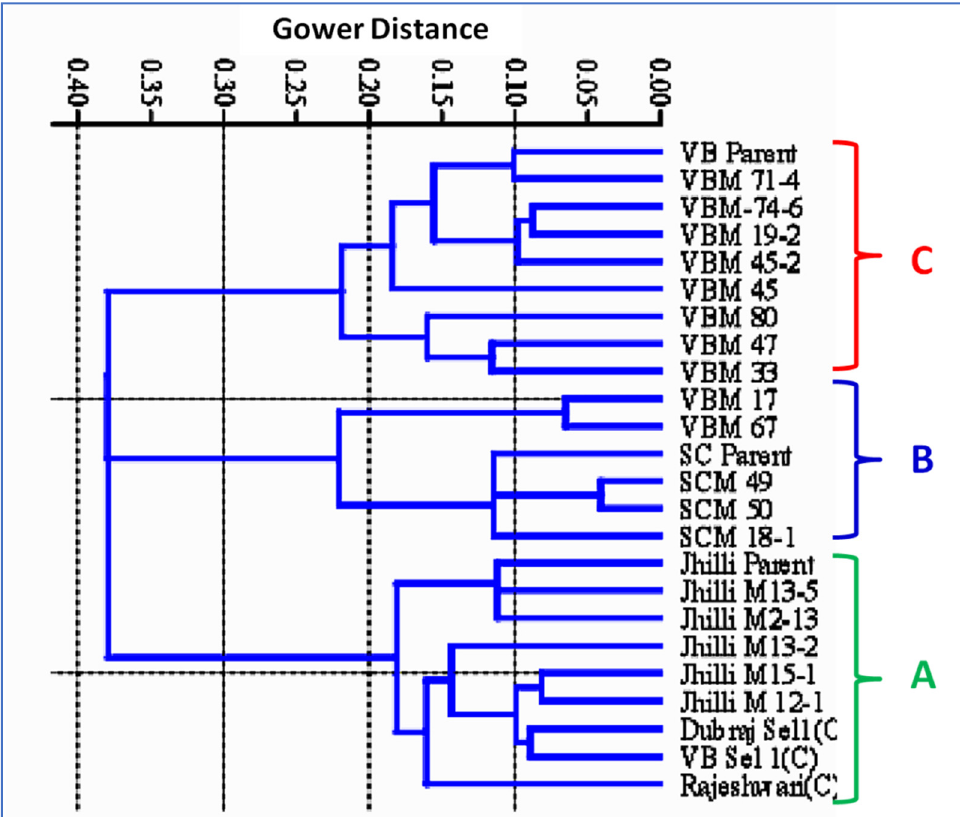
Figure 9. SSR marker-based cluster diagram (dendrogram) showing the similarities and dissimilarities between the mutants and parents .